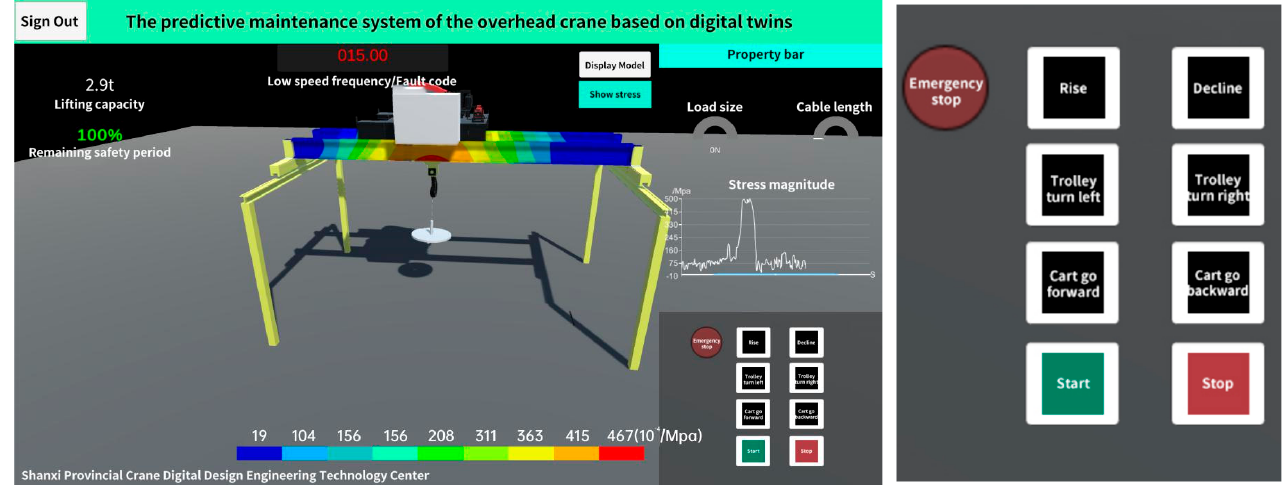
Figure 14. Display of stress and strain.